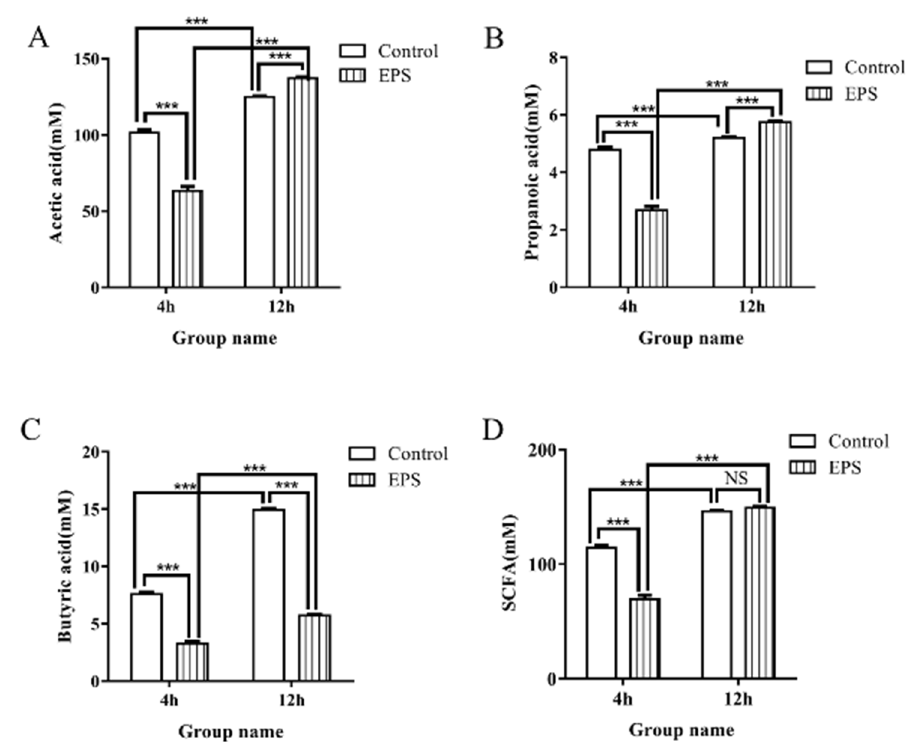
Figure 14. Mean concentrations of acetate ( A ), propionate ( B ), butyrate ( C ), and total short-chain fatty acids (SCFAs) ( D ) during in vitro fecal fermentation with intervention of the EPS produced by Lpb. plantarum NMGL2 for 4 h and 12 h. p values < 0.001 is indicated by ***. NS: no